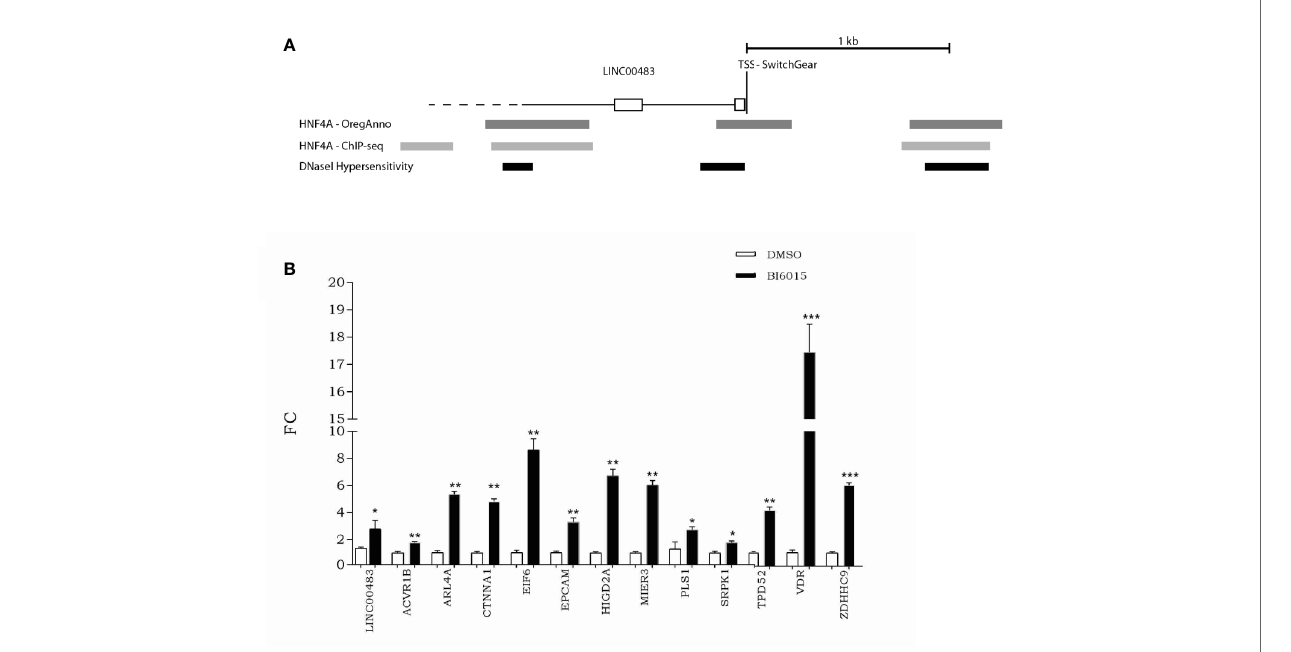
FIGURE 9 | Relationship between LINC00483 and the HNF4 a transcription factor. (A) HNF4 a binding sites and DNase hypersensitive regions upstream and downstream of the transcription start site (TSS) of LINC00483; (B) Expression of LINC00483 and messenger RNAs (mRNAs) potentially involved in LINC00483 axis at 24 h after treatment with BI6015, an HNF4 a inhibitor. *p-value ≤ 0.05; **p-value ≤ 0.01; ***p-value ≤